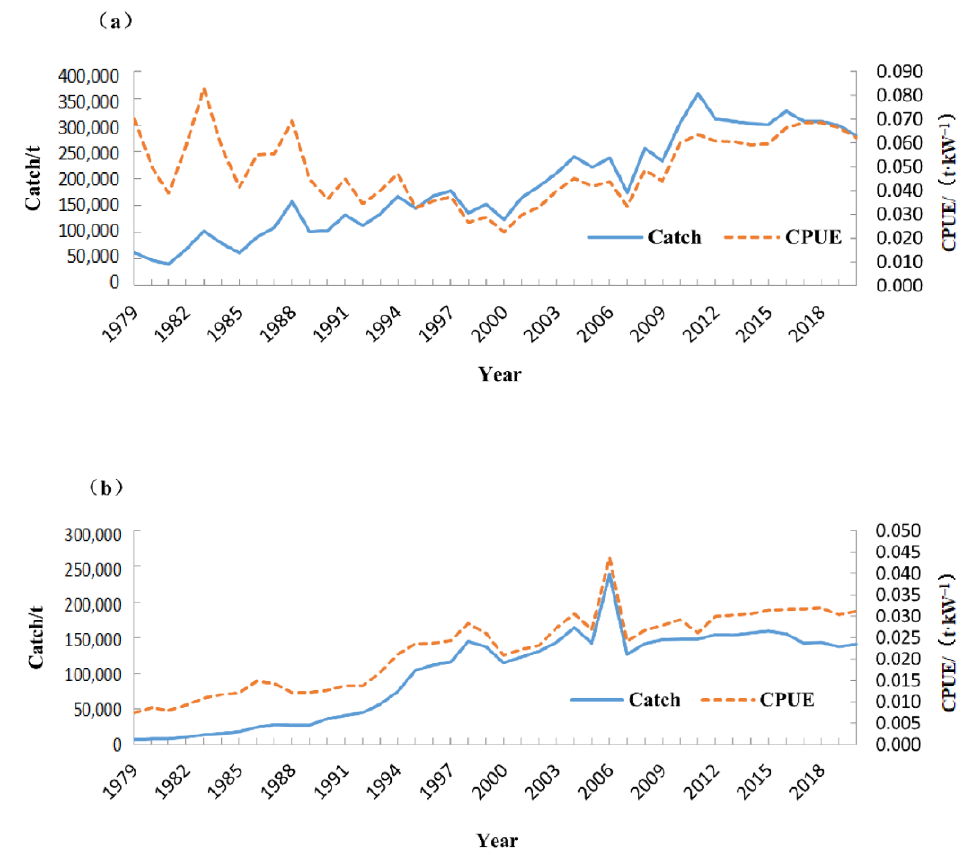
Figure 1. Statistics of catch and CPUE for the Mackerel_ECS ( a ) and Conger_ECS ( b ).